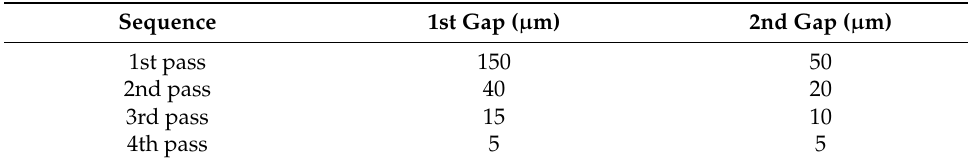
Table 1. Gap between the rolls set in the 3-roll mixing